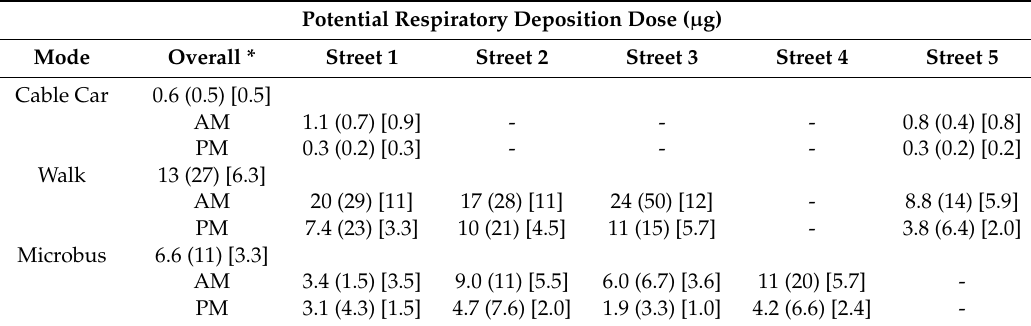
Table 4. Descriptive statistics showing the arithmetic mean (standard deviation, SD) [median] of potential respiratory deposited dose, using eBC exposure concentration at STP conditions and minute ventilation from Milledge [30] on each of the routes, mode of transport, and sampling time. Conversion of eBC RDD to local conditions can be calculated by multiplying the values by 0.68 [36].